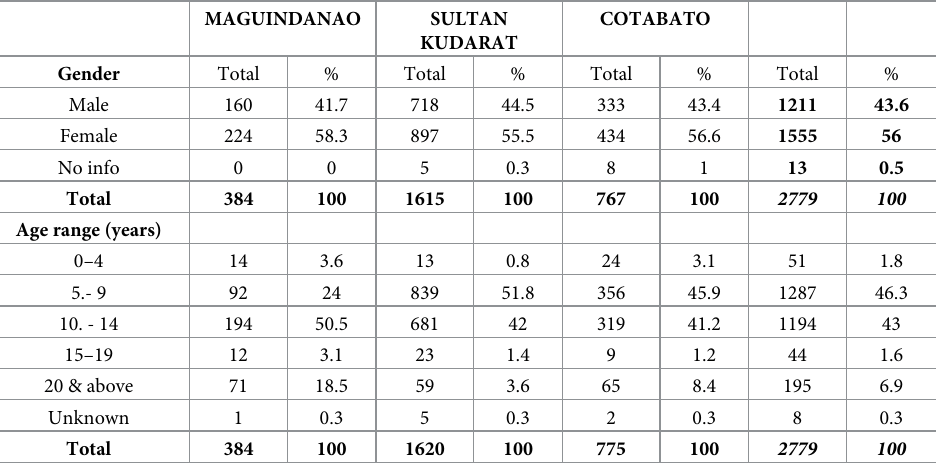
Table 1. Demographic characteristics of all